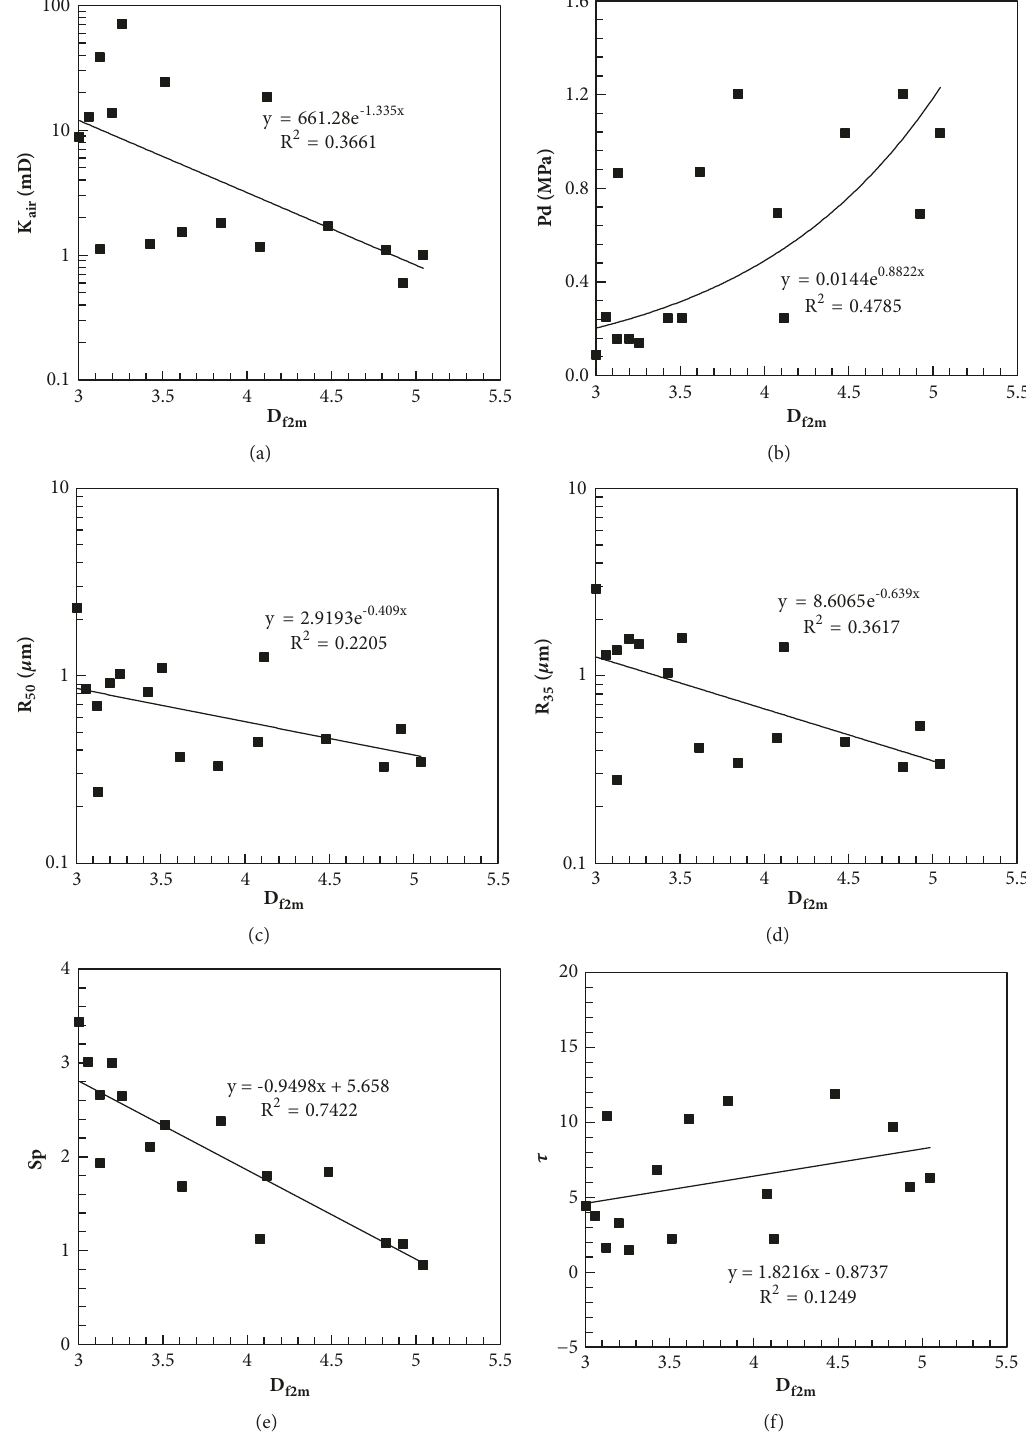
Figure 10: Relationship between fractal dimensions of microscale pores 𝐷 𝑓2 m and some pore structure parameters and petrophysical properties of carbonate core samples ((a) 𝐷 𝑓2 m and air permeability 𝐾 𝑎𝑖𝑟 ; (b) 𝐷 𝑓2 m and displacement pressure 𝑝 𝑑 ; (c) 𝐷 𝑓2 m and 𝑟 50 ; (d) 𝐷 𝑟 𝐷 𝑆 𝐷 𝜏 𝑓2 m and 35 ; (e) 𝑓2 m and sorting coefficient 𝑝 ; (f) 𝑓2 m and tortuosity